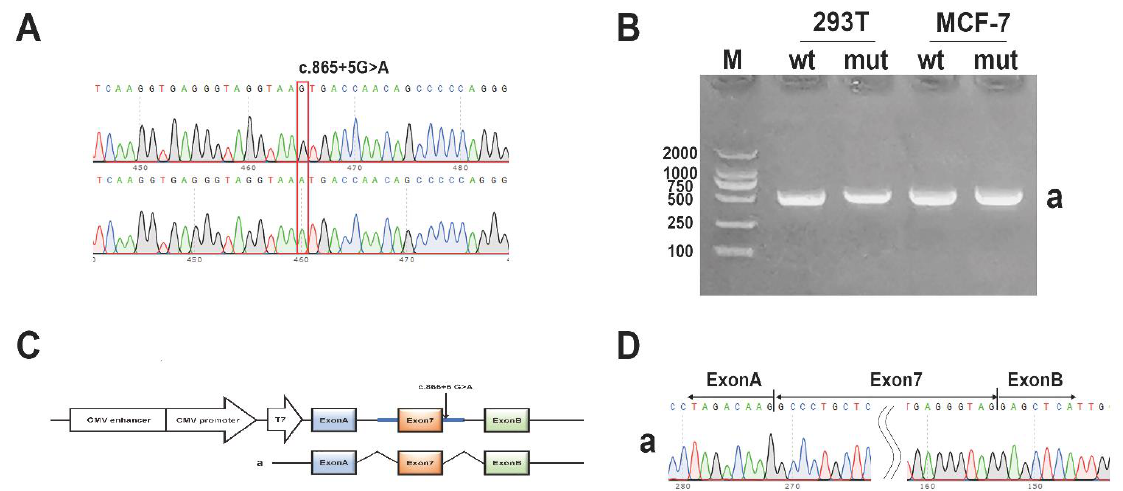
Figure 7. ( A ). Sequencing of the pcMINI-FX-WT and pcMINI-FX-Mut. ( B ). Agarose Gel Electrophoresis for the PCR products in 293T and MCF-7 cells (band a). ( C ) . The construction method of the pcMINI-FX-WT/Mut and splicing mode. Modified pcDNA3.1 with double promoters(CMV promoter and T7 promoter) was used (Thermo Fisher Scientific KK) as vectors. The pcMINI-FX-WT/Mut contains exon7 and intron/exon boundaries, as well as exonA and exonB. ExonA and ExonB are sequences with strong splicing recognition used for splicing study before. ( D ). Sequencing of the PCR products using designed primers.